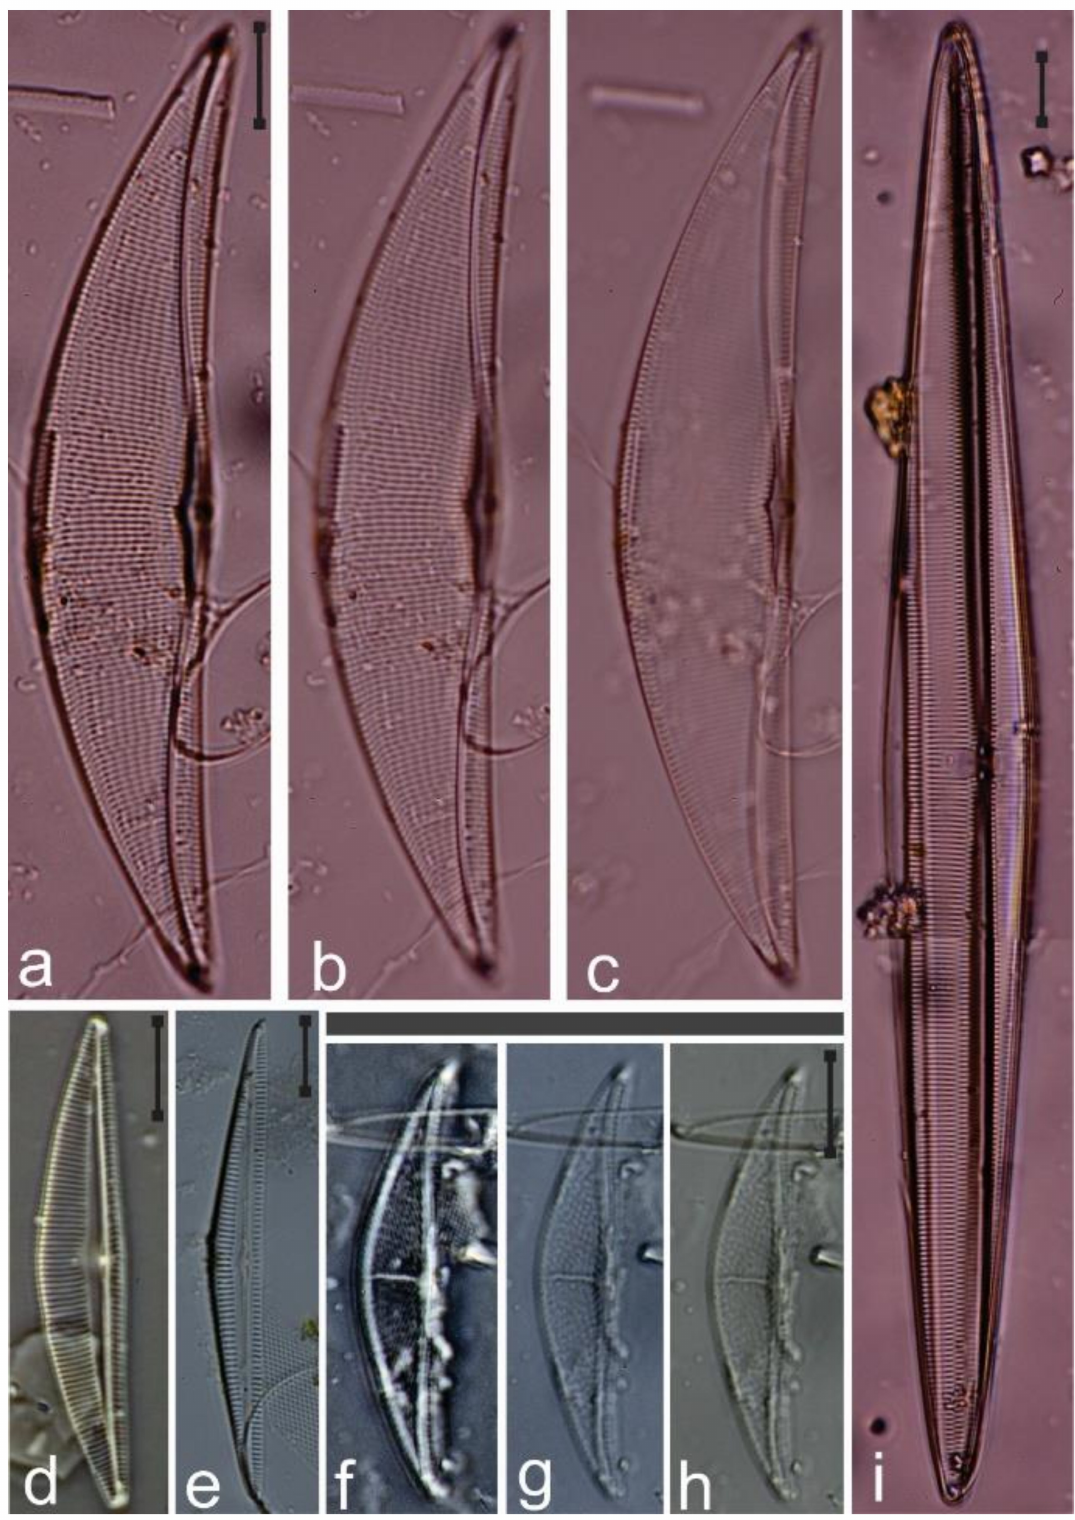
Figure 36. ( a – c ) Tetramphora intermedia in di ff erent focal planes; ( d ) Seminavis robusta ; ( e ) S. macilenta ; ( f – h ) Tetramphora decusata ; ( i ) Plagiotropis australis . Scale bar = 10 µ